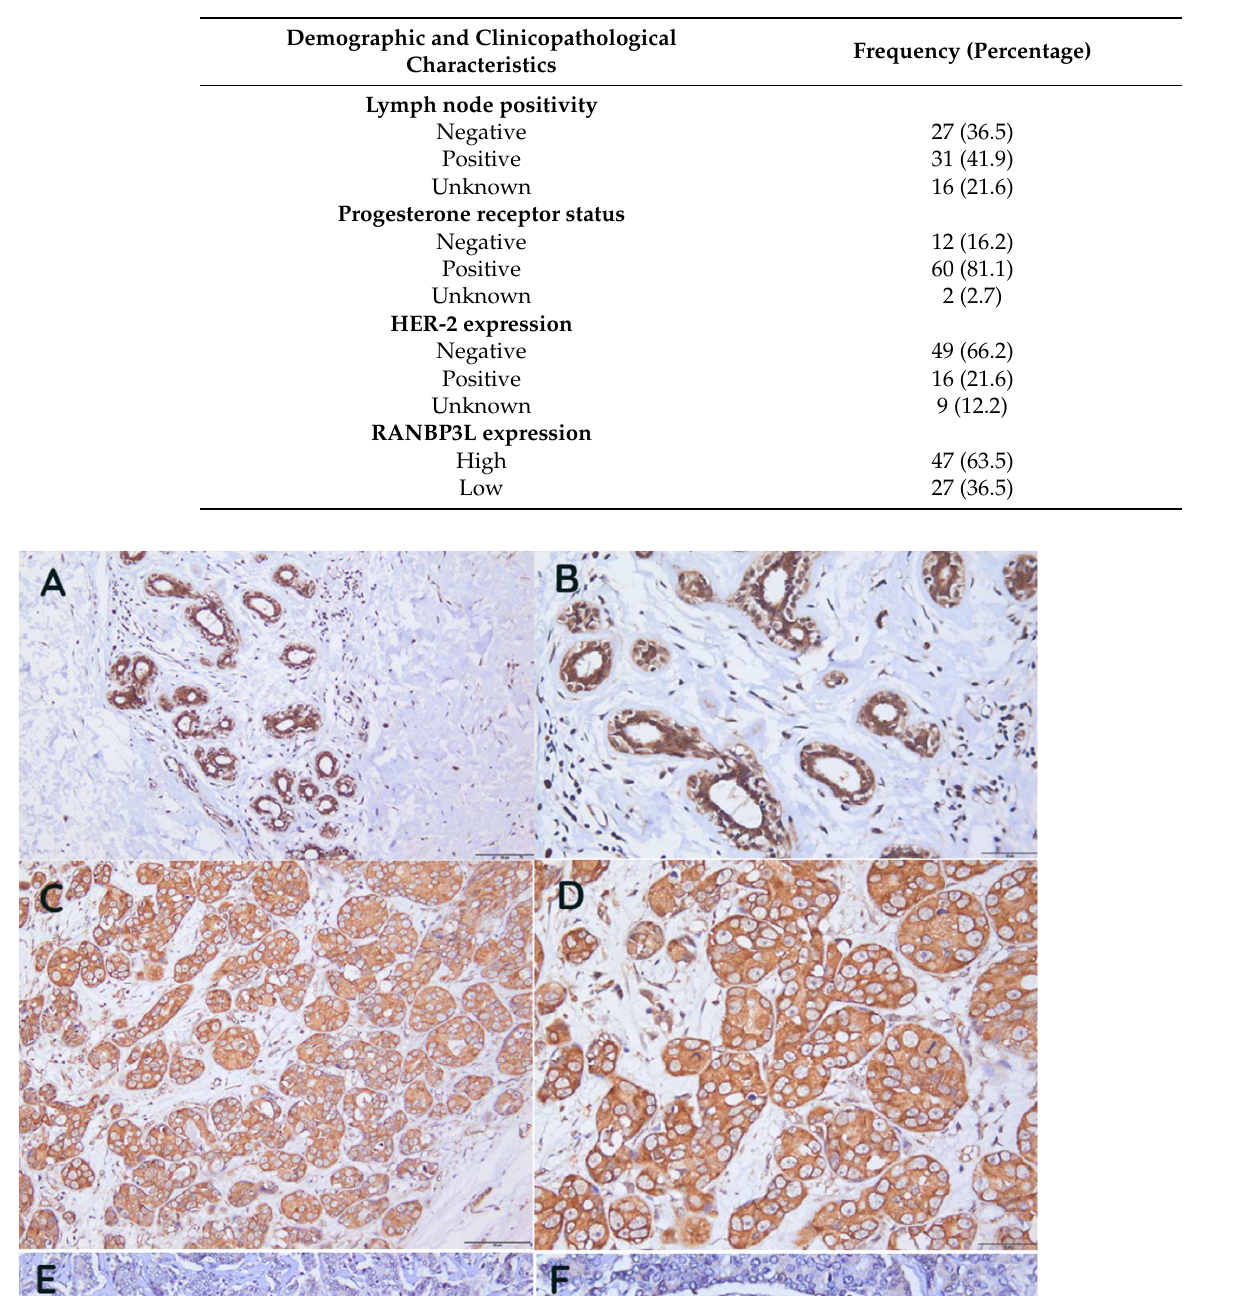
Lower expression of GLYATL-1 was strongly associated with positive lymph node status ( p < 0.005 obtained by Fisher’s exact test). However, no significant association was found between GLYATL-1 expression and the other clinicopathological features includ- ing: age, tumor size, histopathological grade, histopathological subtype, PR and HER-2 status (see Table 6).